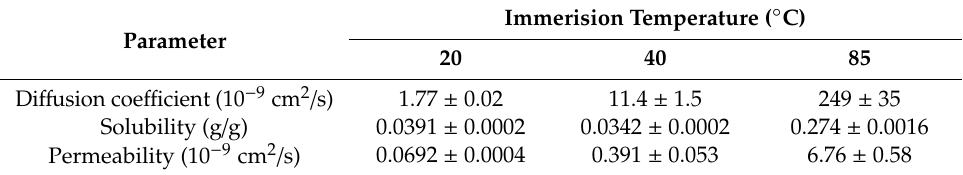
Table 1. Water sorption characteristics assuming successive mechanisms